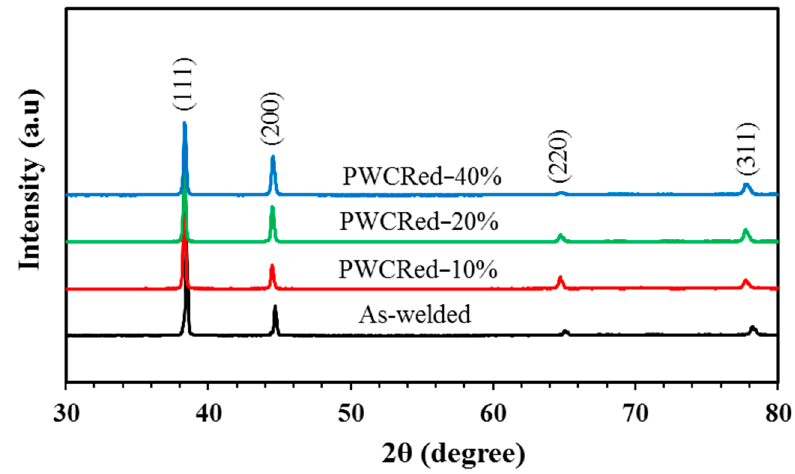
Figure 7. XRD patterns of the as-welded and PWCRed samples.